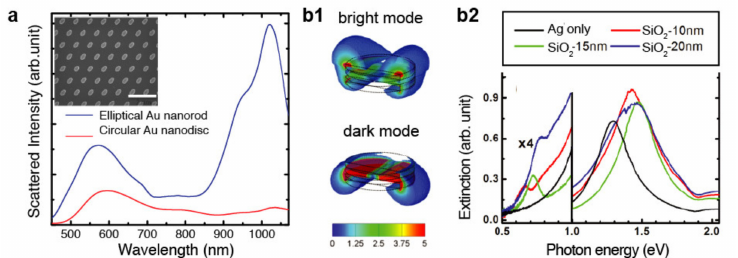
Figure 6. Nanostructures for photonics. ( a ) Measured dark-field scattering spectra of the circular and elliptical Au nanodisks fabricated with nanojet lithography under oblique illumination. The inset shows SEM images of the Au nanoellipses. Reprinted with permission from [97] Copyright 2012 The Japan Society of Applied Physics. ( b1 ) Simulated energy field of the bright and dark mode of an Ag-SiO 2 -Ag dimer. ( b2 ) Experimental extinction spectra of Ag-SiO 2 -Ag dimers with thickness 15 nm for Ag and 10, 15 and 20 nm for SiO 2 . The low energy side of the spectra highlights the shift of the dark plasmon mode when varying the SiO 2 thickness. Adapted with permission from [94] Copyright 2012 American Chemical